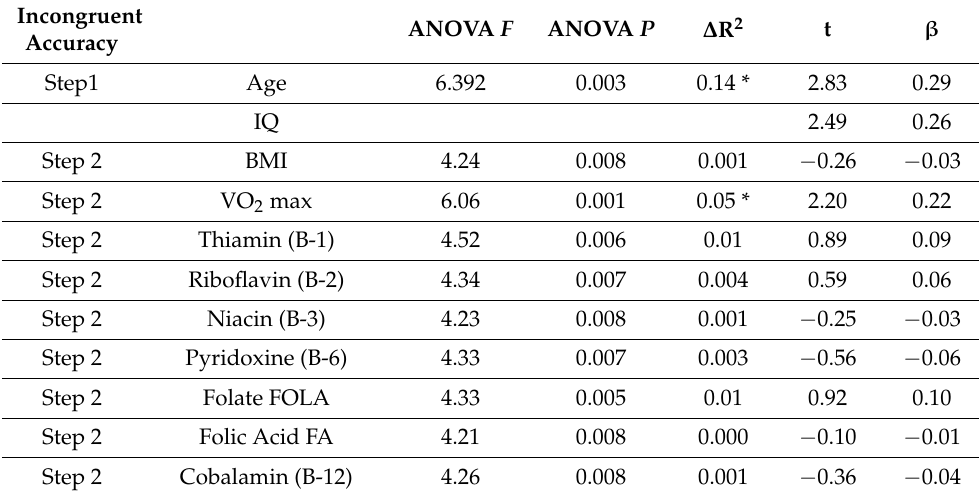
Table 4. Incongruent Accuracy Regressions.